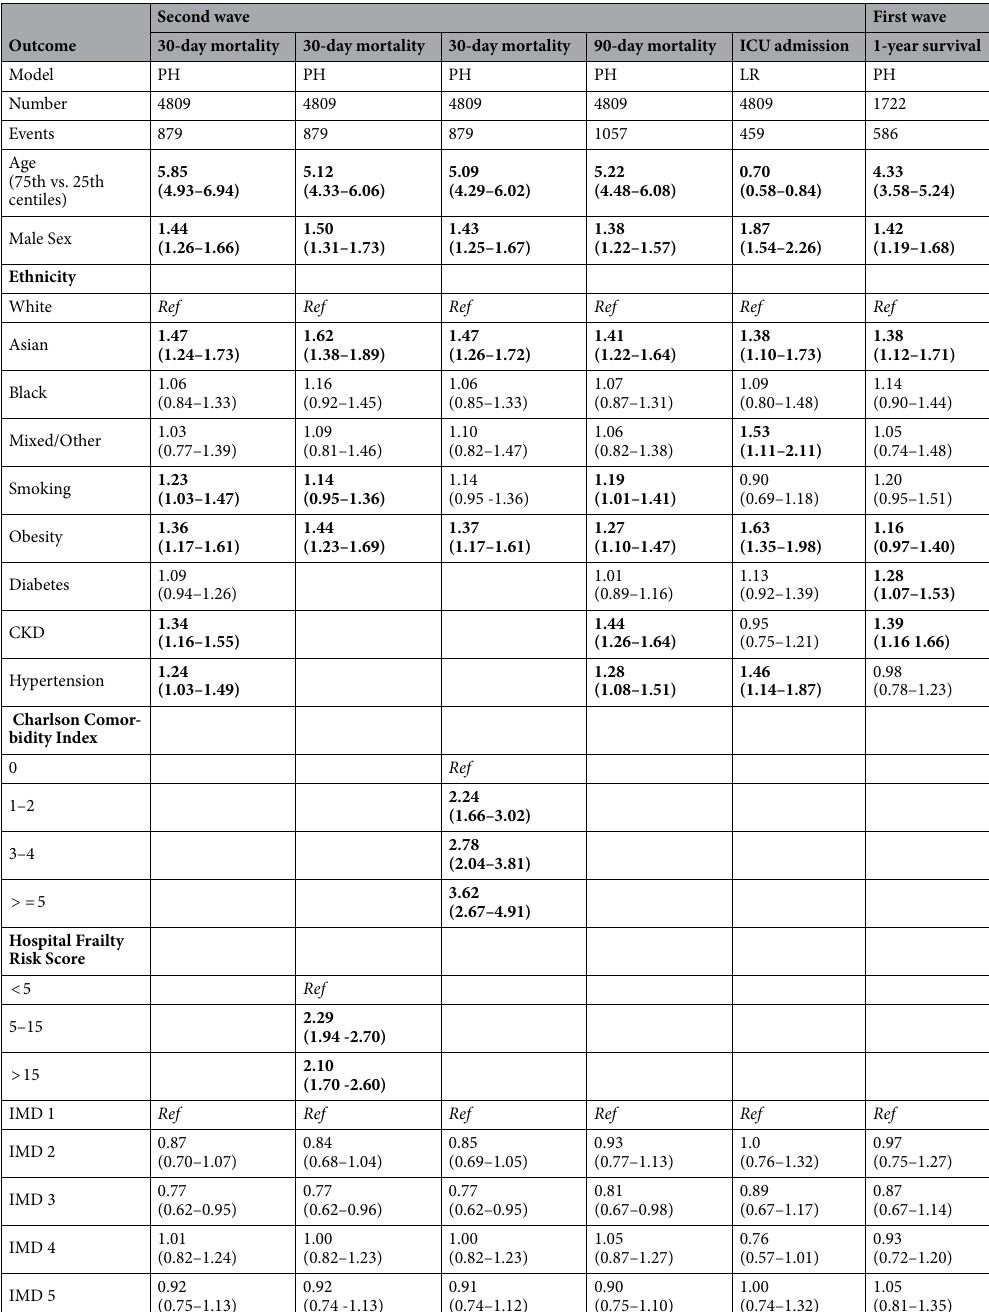
Table 2. Multivariable modelling (PH: Proportional Hazards, LR: Logistic Regression). Significant values are in